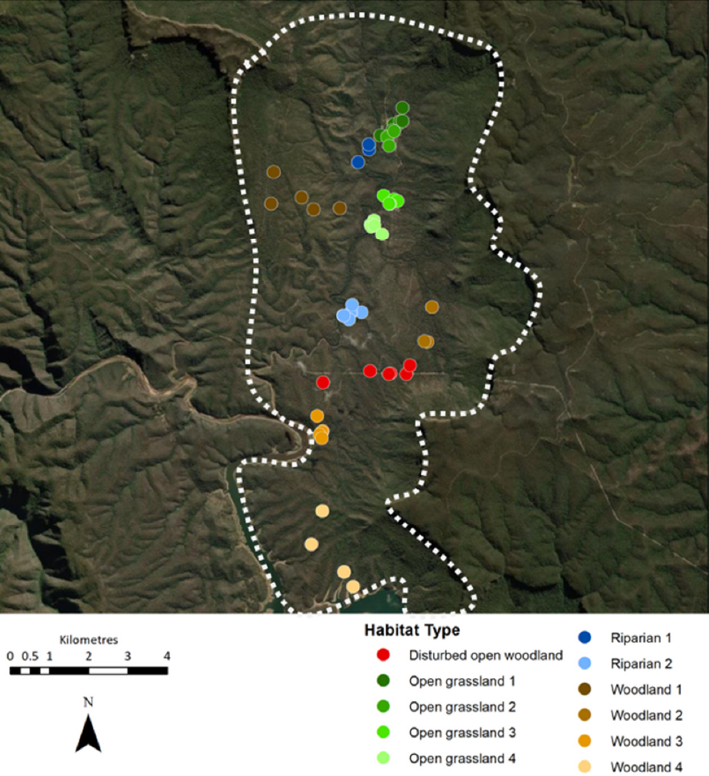
Figure 1. Topographical map of the study area illustrating camera locations and habitat types in the 11 areas. The white dashed line represents the geographic boundaries that inhibit immigration and emigration of this horse population.